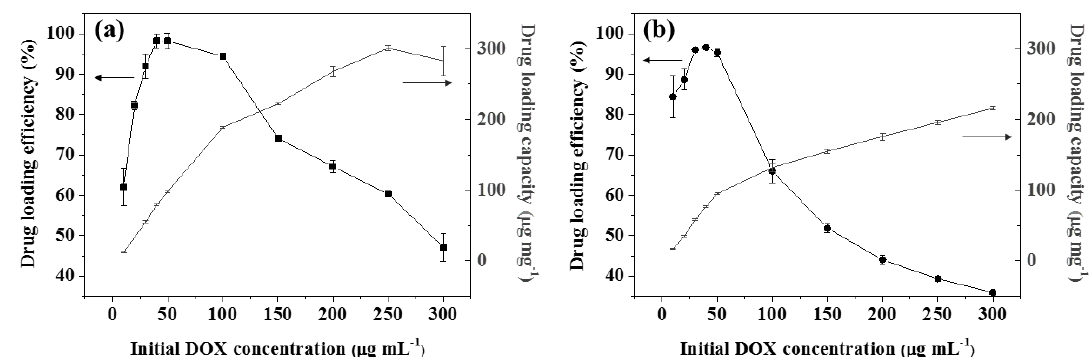
Figure 5. The drug loading profiles of GbMNPs at different initial doxorubicin (DOX) concentrations (10–300 µ g · mL − 1 ). ( a ) GbMNP-2; ( b ) GbMNP-3. Error bars represent the standard deviation of triplicate drug loading tests.